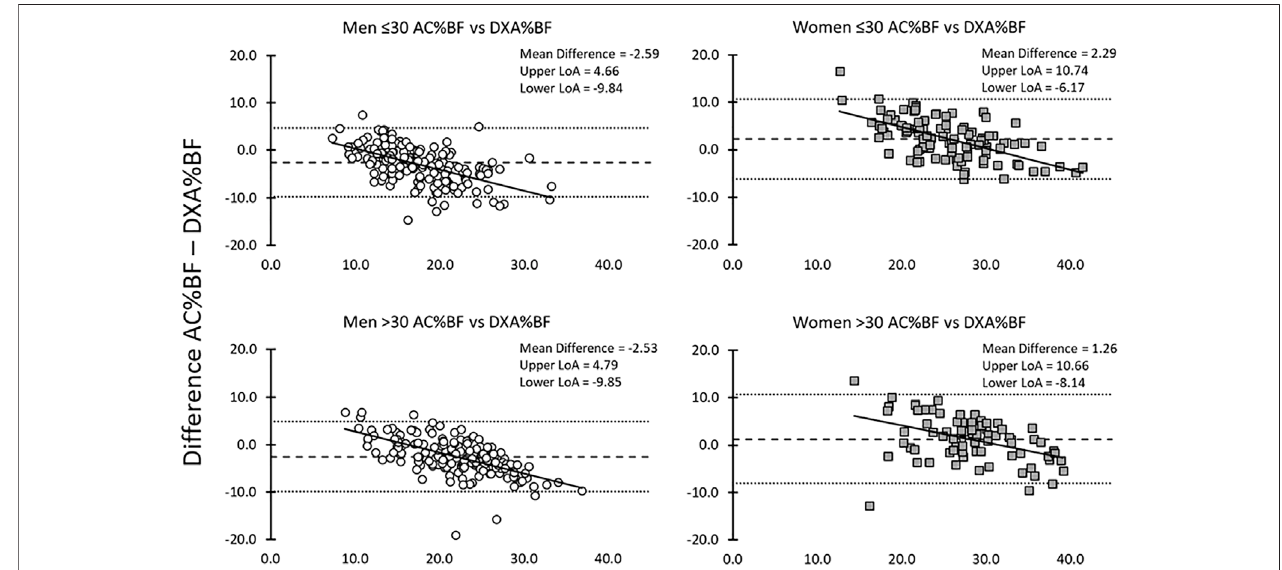
FIGURE 4 | Bland-Altman BIA to DXA %BF for men and women for each age group ( ≤ 30 and > 30).